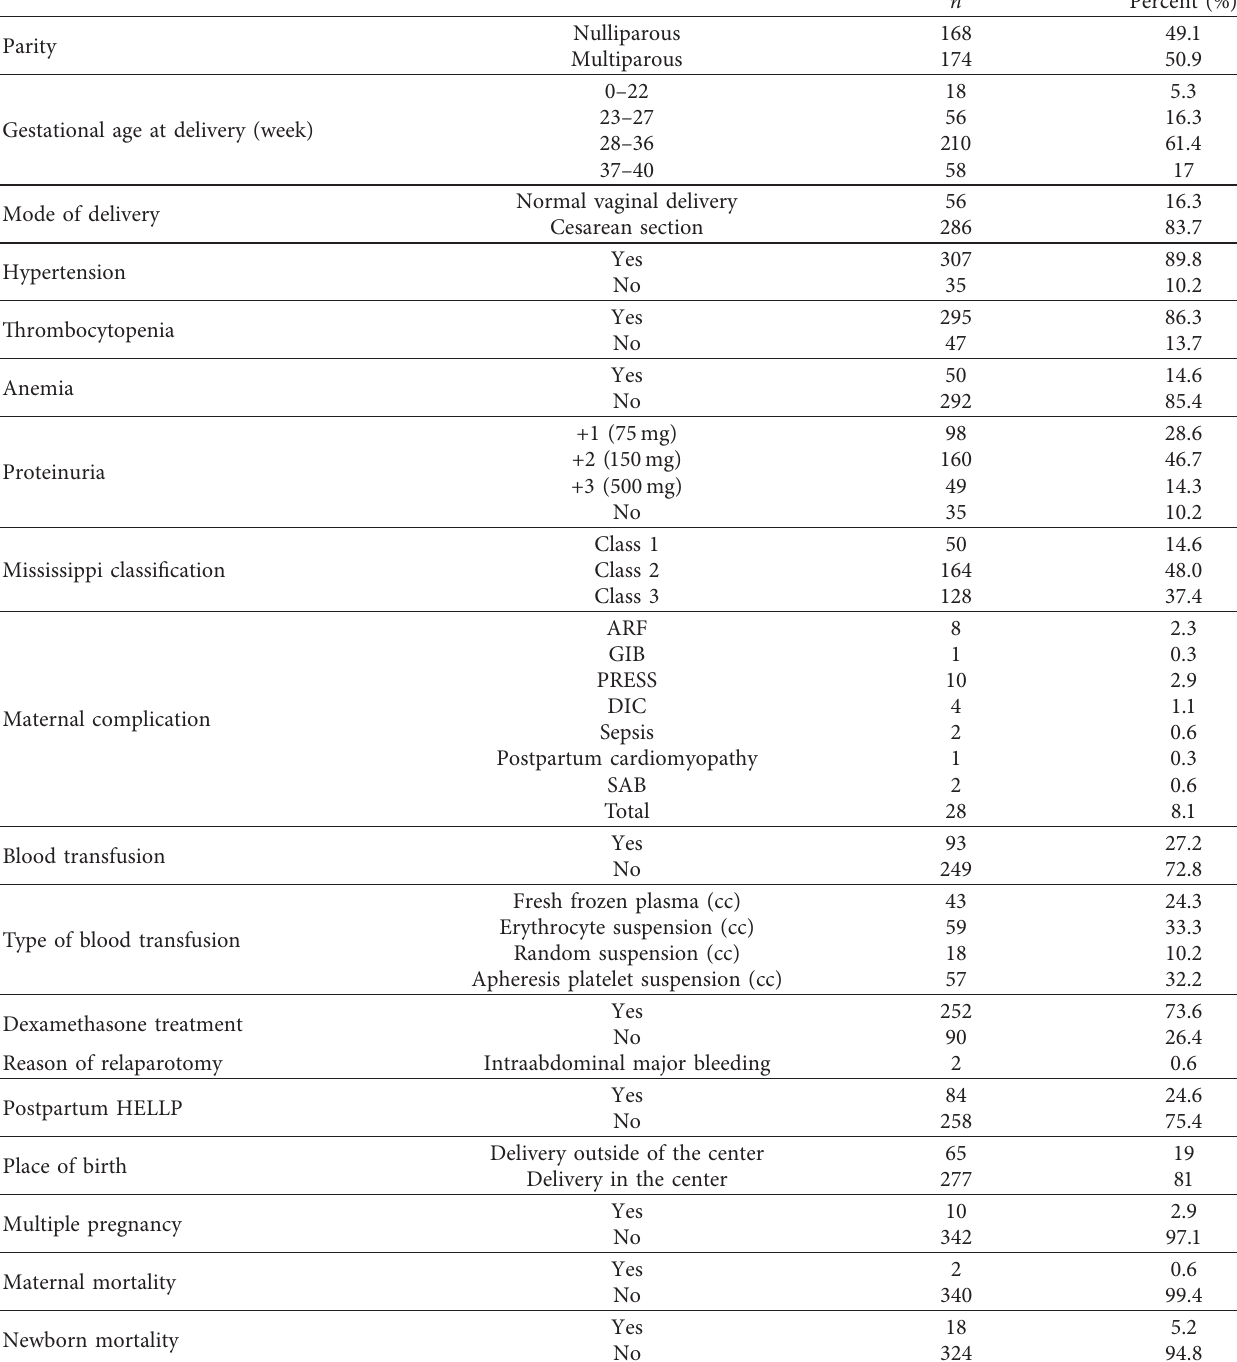
Table 1: Evaluation of demographic and laboratory findings in the patients with HELLP